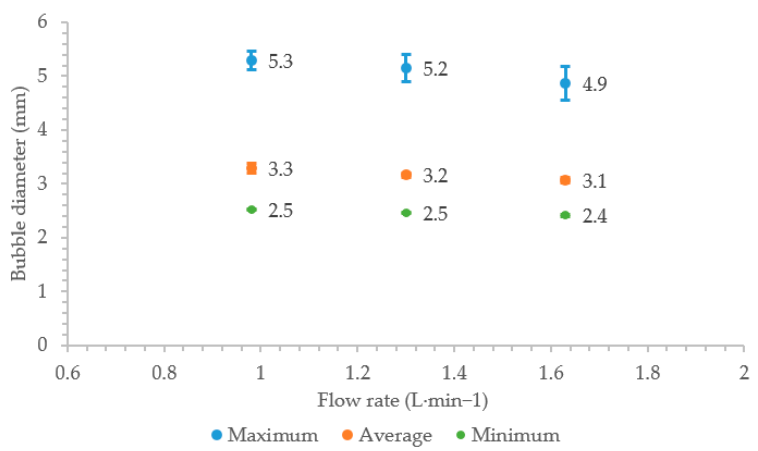
Figure 4. The maximum, average, and minimum values of bubble size in the water experiment.